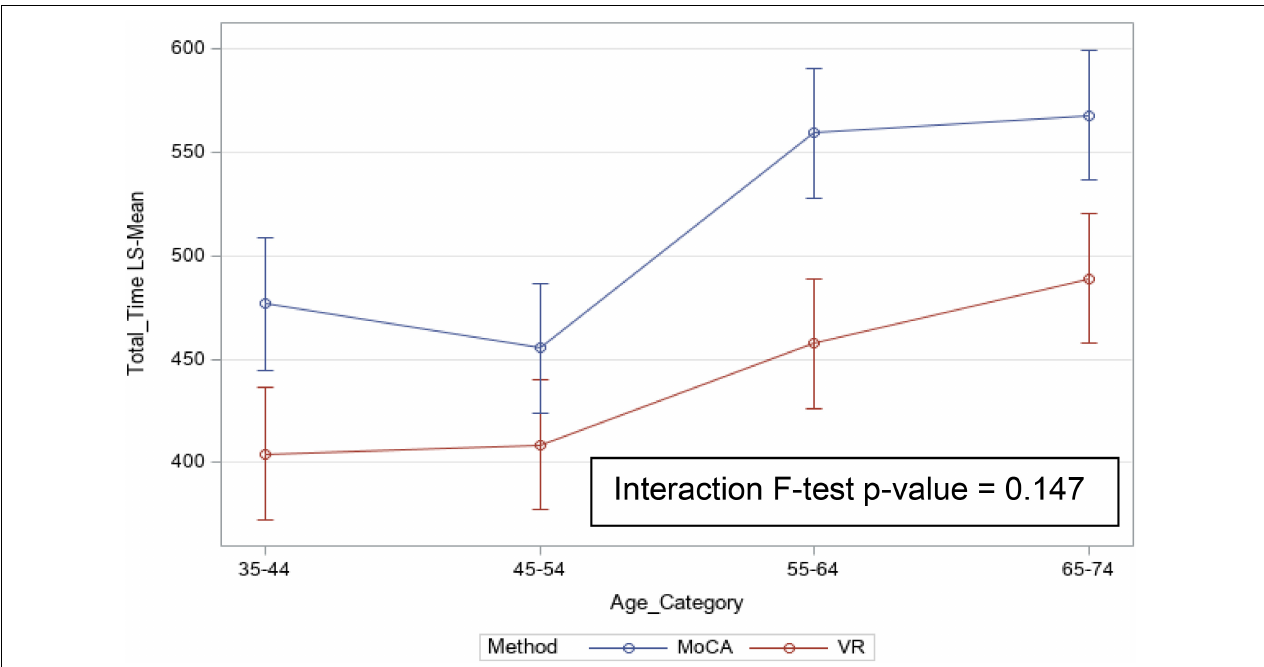
FIGURE 6 | Mean (95% CI) total time taken (sec) for MoCA and VR